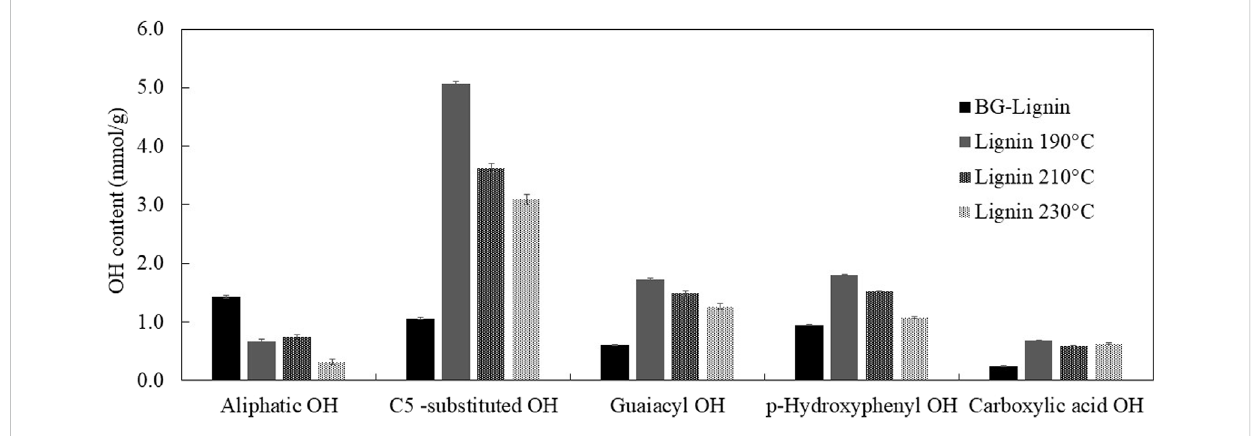
FIGURE 3 Aliphatic and phenolic hydroxyl content in organosolv lignin extracted from bagasse before and after thermal modi fi cation.